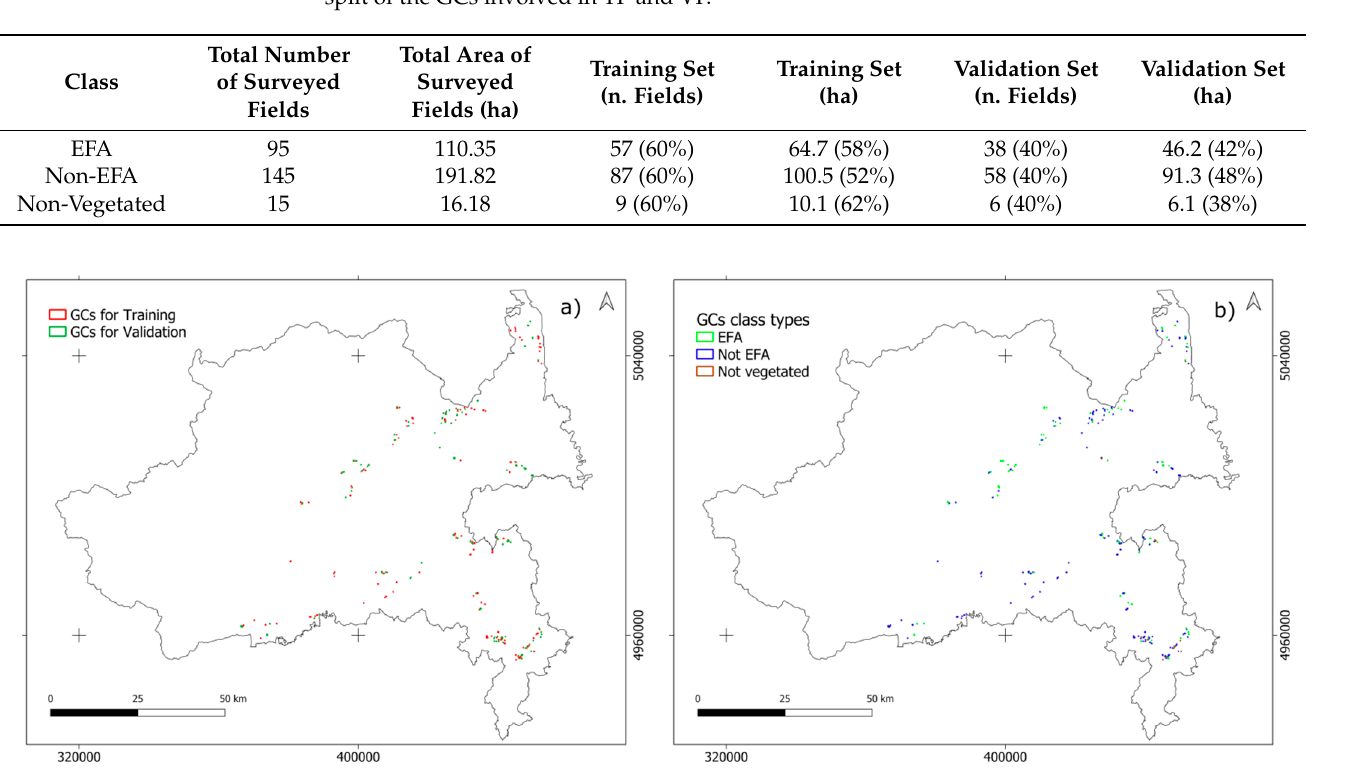
Table 1. Number and size of surveyed fields carried out by the ARPEA per class type and relative split of the GCs involved in TP and VP.